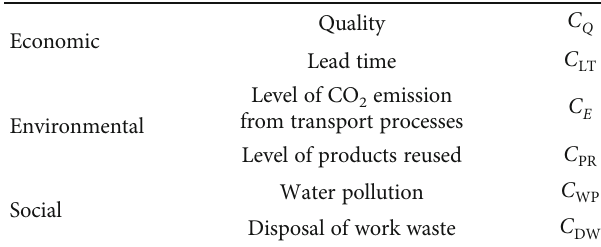
Table 7: Top six SD cost variables for inventory management (own